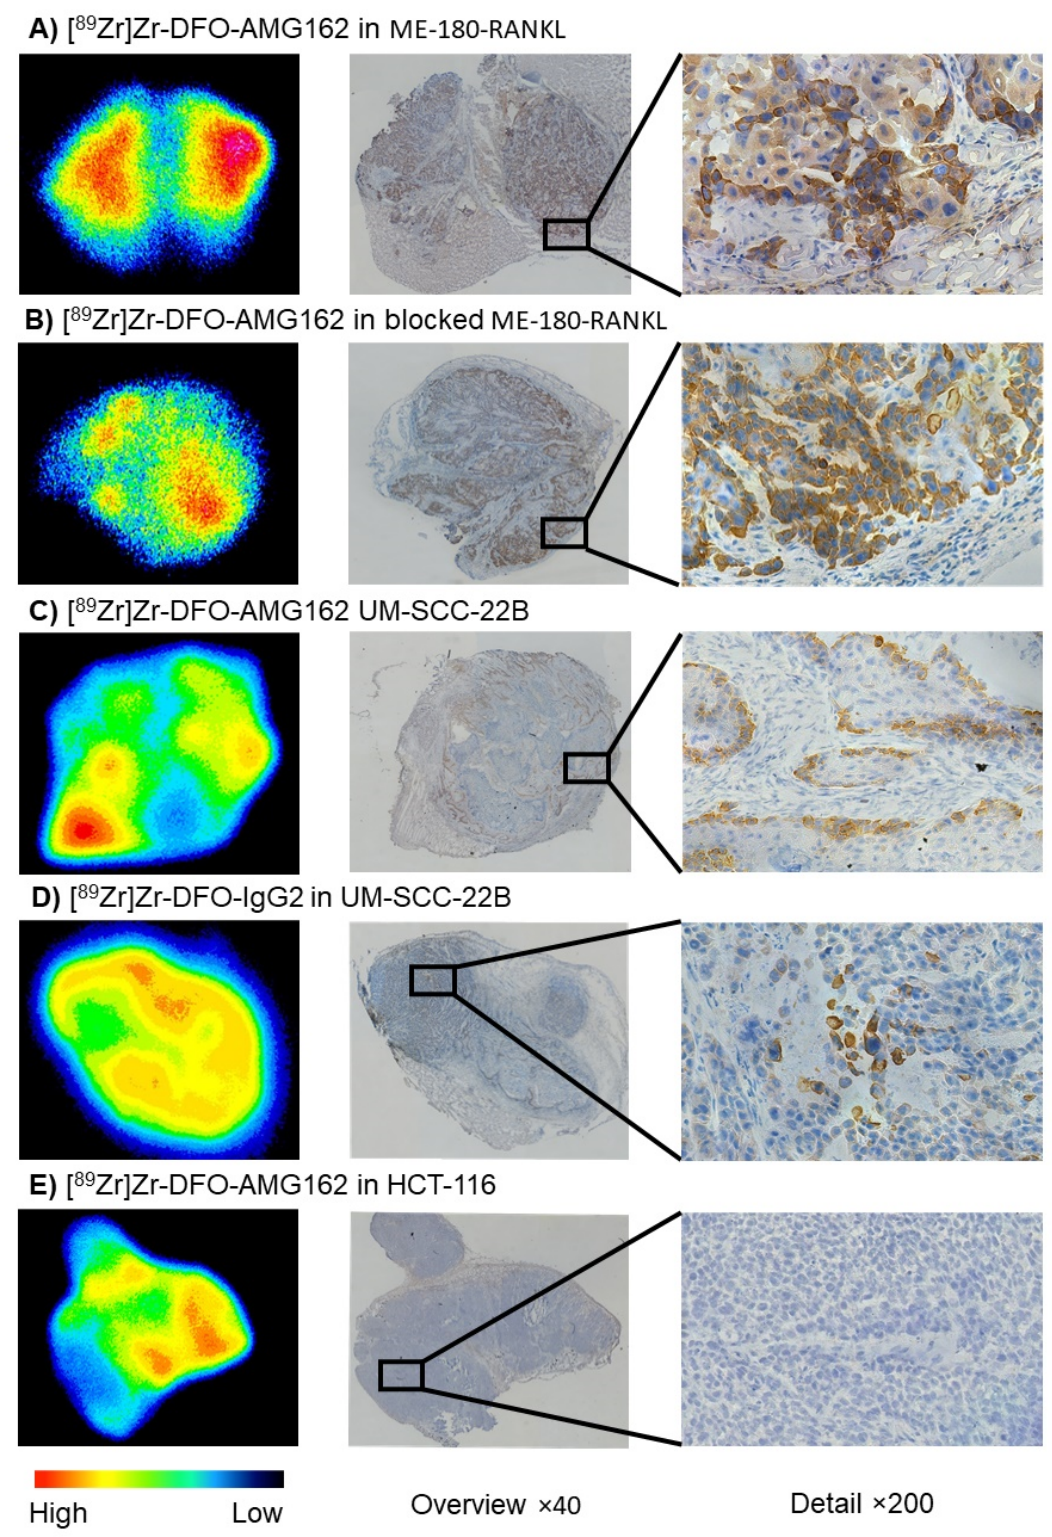
Figure 4. Autoradiography (High-Low (counts)), adjacent RANKL IHC (brown stain) overview image ( × 40), and detailed RANKL IHC image ( × 200) in xenografts: ( A ) [ 89 Zr]Zr-DFO-AMG162 in ME-180-RANKL, ( B ) [ 89 Zr]Zr-DFO-AMG162 in blocked ME-180-RANKL, ( C ) [ 89 Zr]Zr-DFO-AMG162 in UM-SCC-22B, ( D ) [ 89 Zr]Zr-DFO-IgG2 in UM-SCC-22B and ( E ) [ 89 Zr]Zr-DFO-AMG162 in HCT-116.